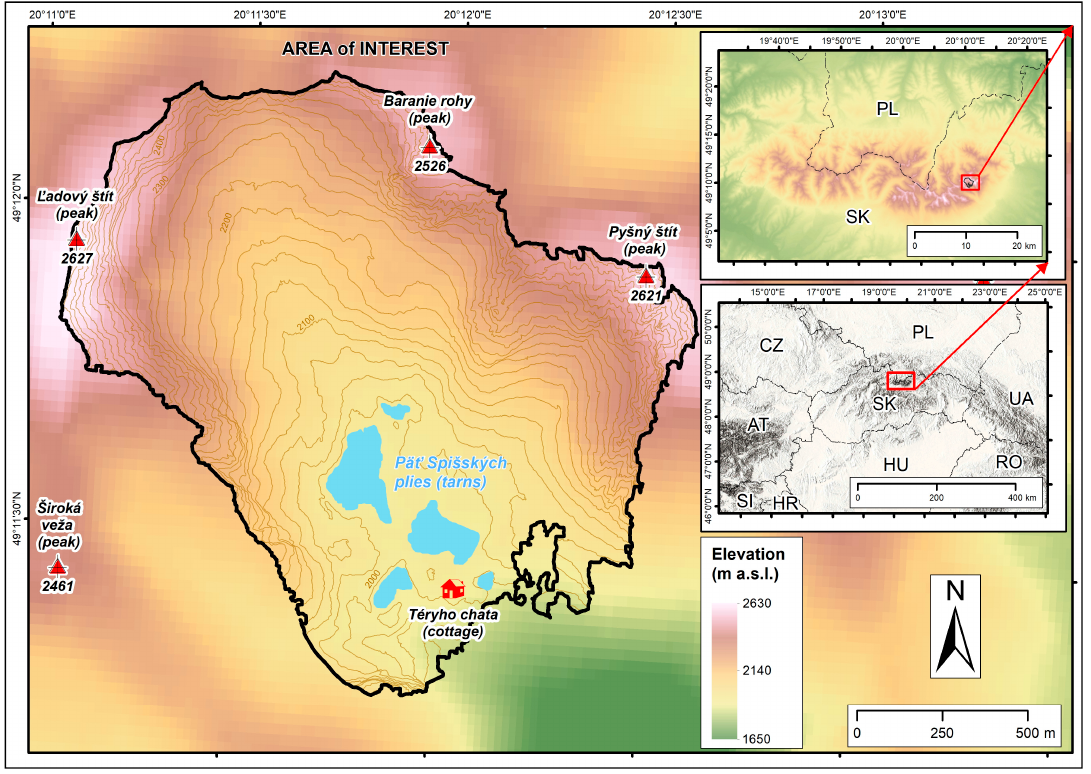
Figure 3. Location of the area of interest. Background digital elevation model (DEM) and shaded relief derived from SRTMGL1.V003 in spatial resolution 30 m © NASA JPL (https: // earthexplorer.usgs.gov / ) vertical interval of contours is 25